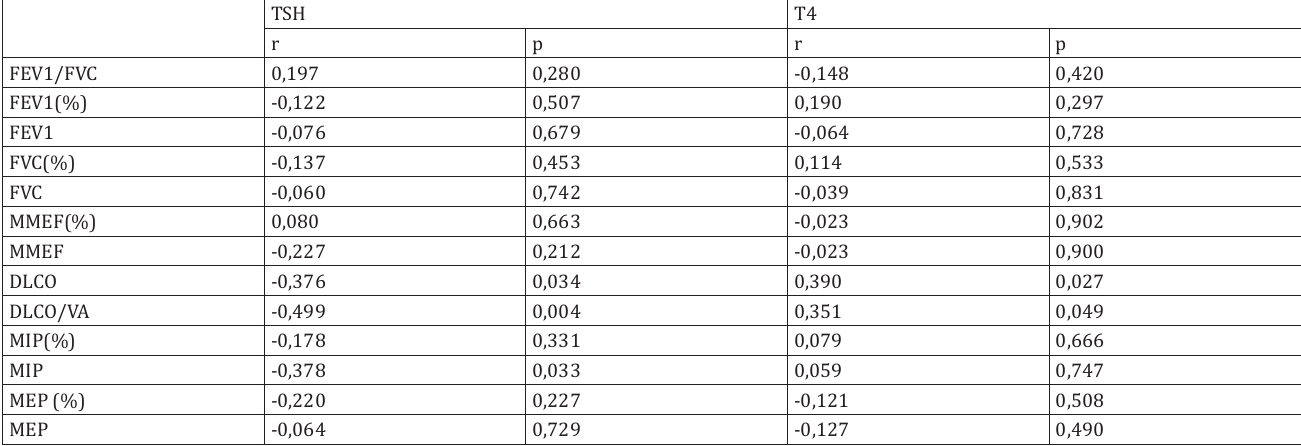
Correlation between thyroid function tests and pulmonary function tests